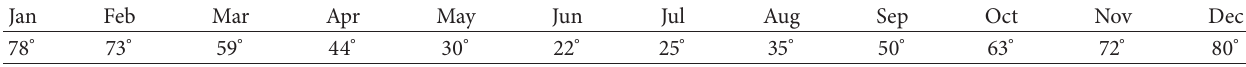
Table 2: Optimal monthly module inclination angles from the horizontal plane for TUT location according to [20].